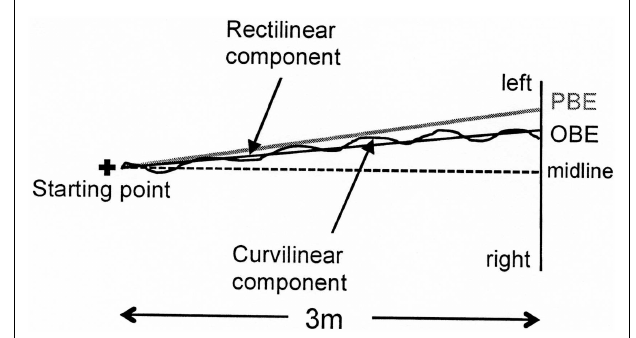
FIGURE 3 | Graphic representation of a typical walking trajectory of patient MR and its components: (1) a major rectilinear component and (2) a curvilinear component forming a second-order polynomial curve (the progression curve) whose intersection point with the target line corresponds to the observed bisection error (OBE) .The point of intersection with the target line of the tangent to the “progression curve” at the starting point identifies the bisection error predicted by the first walking step (PBE).